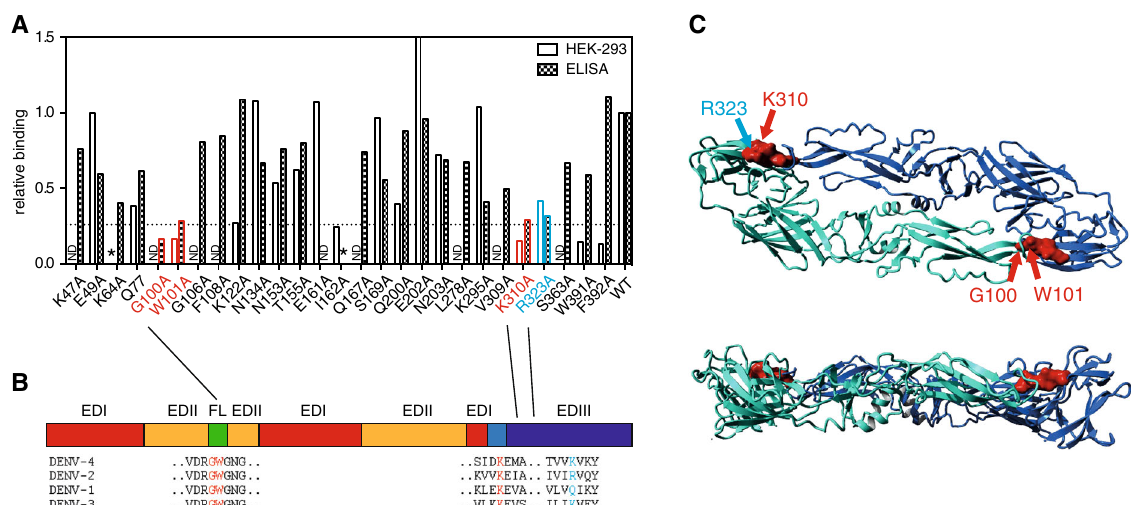
Fig. 6 Binding sites of SIgN-3C. a Epitope mapping using mutated E proteins in ELISA ( fi lled bars ) and mutated E protein expressed on the surface in HEK-293T cells ( empty bars ). Bars are means of duplicates and results are representative of three and two independent experiments, respectively. Red bars indicate likely binding sites of SIgN-3C as shown by a 75% reduction of binding in one and/or both assays. Blue bars indicate a possible binding site shown by 70% reduction in binding. ND: not done. *: misfolded protein in either the HEK or ELISA assay, I162 was therefore not included as part of the epitope. 75% reduction is indicated by the dotted line . b Illustration of the proposed binding sites on the soluble part of the E protein. The individual domains of the E protein are indicated in different colors according to. 49 Red : EDI, yellow : EDII, blue : EDIII, light blue : EDI-EDIII linker, green : FL (fusion loop). Sequence alignment of the binding sites for all four DENV serotypes is shown with the binding sites highlighted in red and blue . c Illustration of the proposed binding sites on the dimeric structure of the E protein in top-down and side view. The individual residues are indicated with arrows in the turquoise E